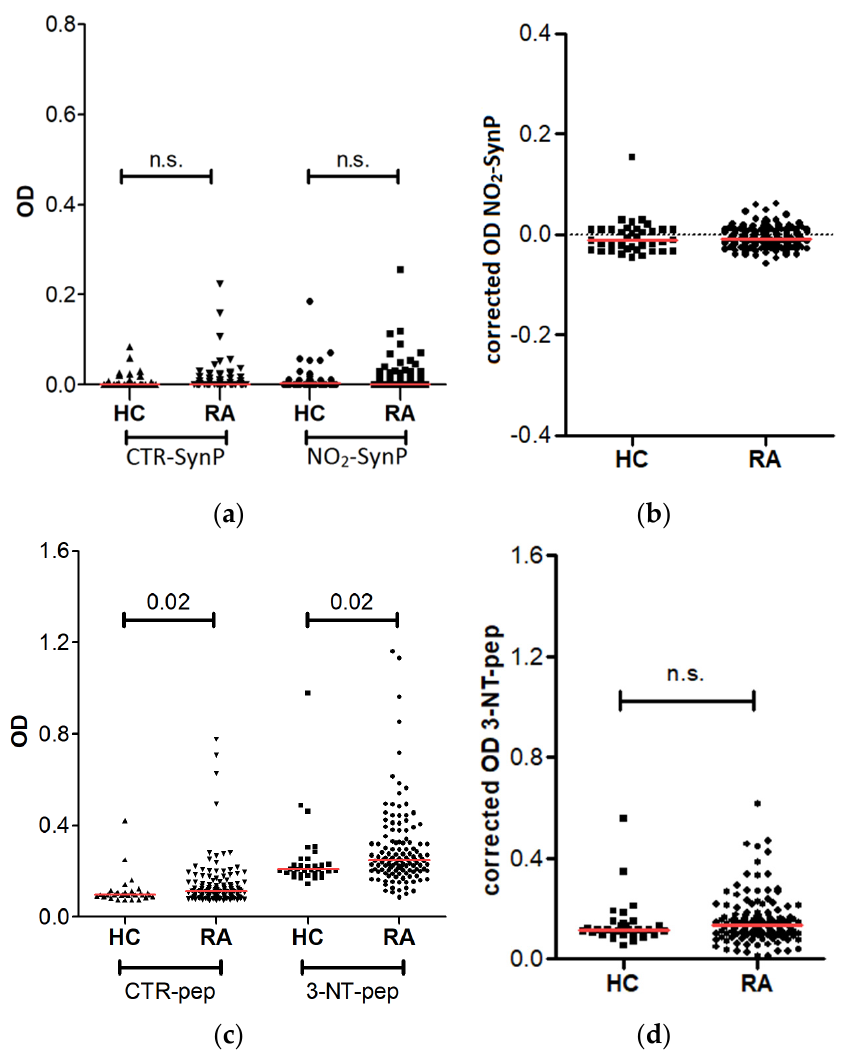
Figure 2. Reactivity against nitrated proteins and peptides in RA patients and healthy controls. ( a ) Uncorrected; and ( b ) corrected OD of the reactivity against NO 2 -SynP; ( c ) uncorrected; and ( d ) corrected OD of the reactivity against a 3-NT-pep. The red line represents the median OD value in each group. n.s. = non